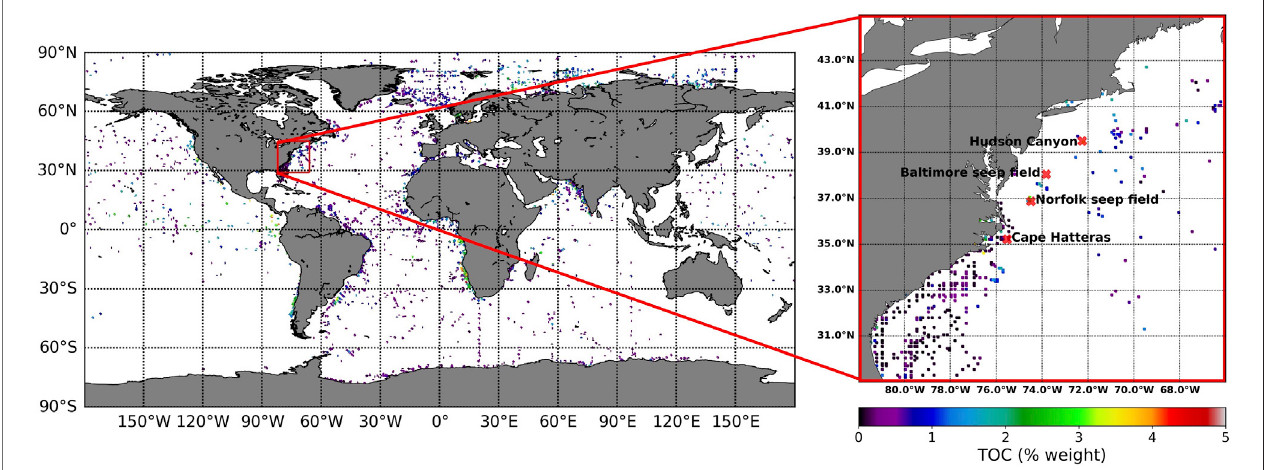
FIGURE1| Knownmeasurements oftotal organiccarbon (TOC)globallyand withinthearea29 ° N – 45 ° Nand82 ° W – 66 ° W.Inthezoomed inregion, thelocationsof Hudson Canyon, Baltimore seep fi eld, Norfolk seep fi eld, and Cape Hatteras are also indicated.